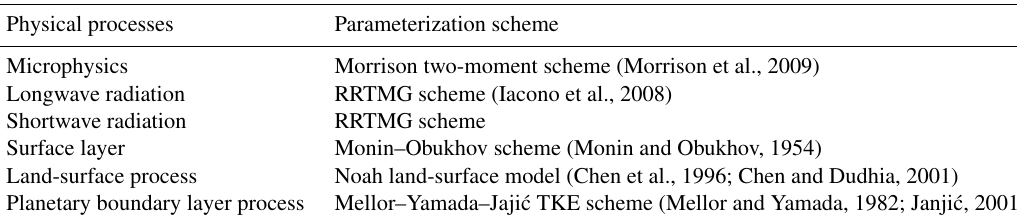
Table 1. Configurations of the WRF physics schemes used in the present study.